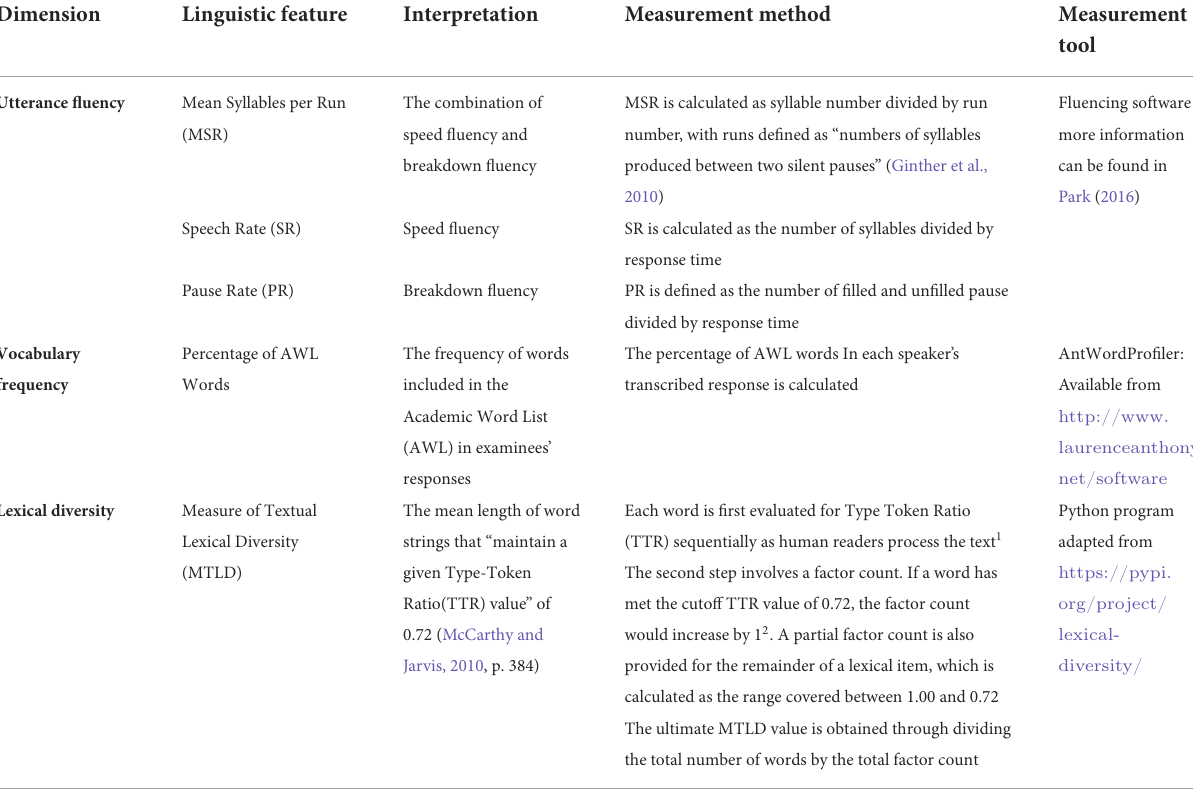
TABLE 2 Utterance fluency and vocabulary measures included for cluster analysis.